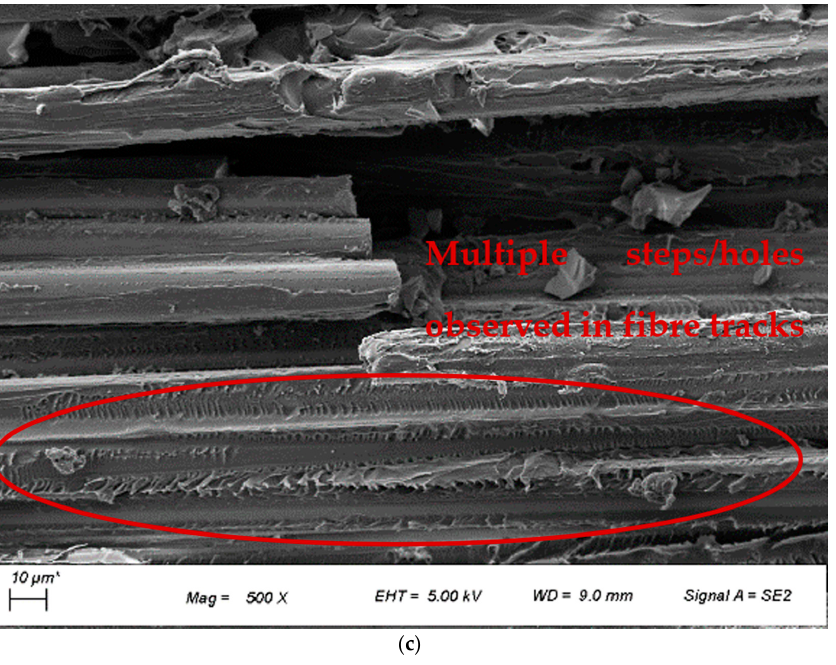
Figure 4. FESEM images of BF-PC composites processed at pre-consolidation temperatures of ( a ) 170 °C (u), ( b ) 260 °C, and ( c ) 280 °C.